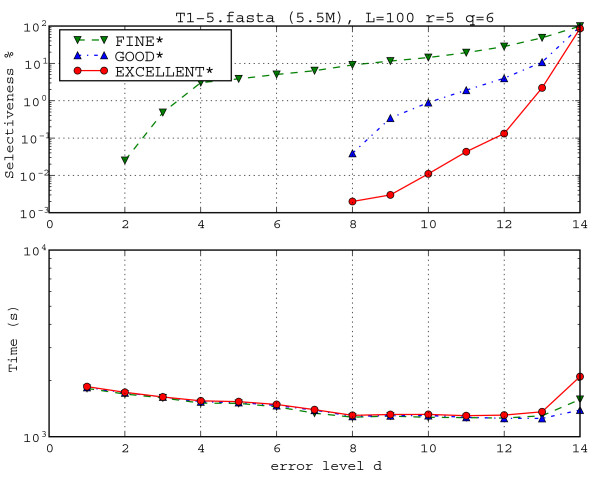
Influence of maximal error d over selectiveness and running time. Influence of maximal error d over selectiveness and running time for CFTR dataset with parameters (L, d, r) = (100, d, 5) with q = 6. A selectiveness of 0 is not drawn because of the log scale.